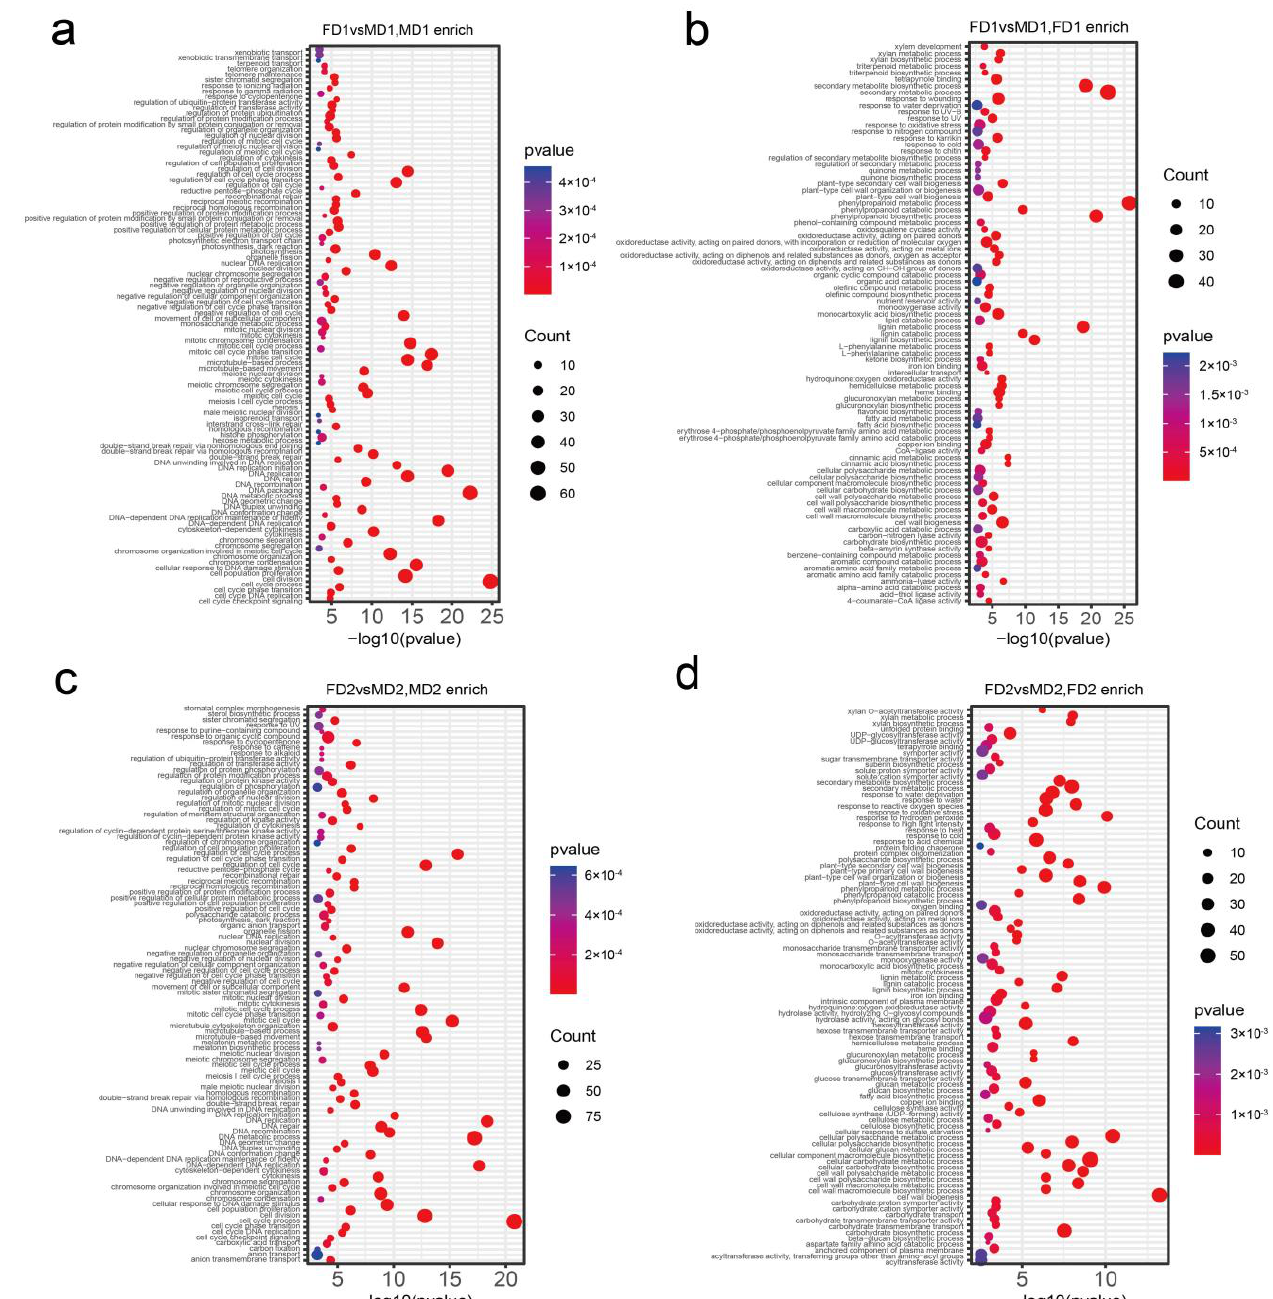
Figure 5. GO (biological process) enrichment analysis of initial differentiation of flower buds and the formation of flower primordial. The top 100 enriched GO terms were presented in each comparison. The enriched GO of the initial differentiation stage of ( a ) male (MD1) and ( b ) female (FD1) flower buds and the formation of the flower primordial stage of ( c ) male (MD2) and ( d ) female (FD2) flower buds. The vertical and horizontal axes represent the uniqueness of GO terms and enrichment factors, respectively. Scale bars are log 10 p -values, and the size of circles represents the number of genes enriched in GO terms.